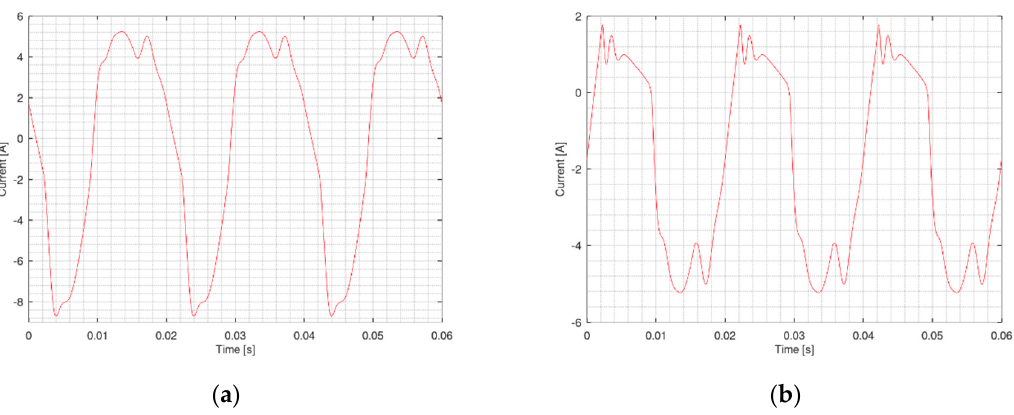
Figure 15. Current in the time domain through ( a ) the generator; ( b ) inductance 𝐿 (cid:2869) .